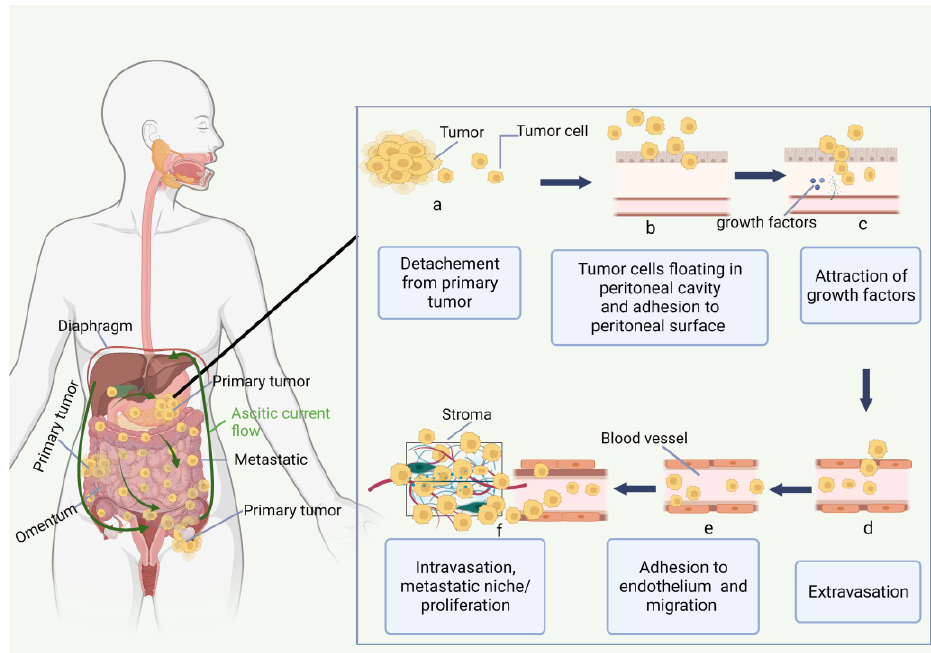
Figure 1. The development of peritoneal carcinomatosis: ( a ) The cancer cells dissociate from the main tumor and ( b ) penetrate the epithelial tissue. Cancer cells that have exfoliated invade the underlying basal lamina and stroma. ( c ) Stromal cancer cells defy apoptosis and entice growth substances that stimulate proliferation and angiogenesis. ( d ) After breaking through the endothelial cells that border the vessels, cancer cells spread to other parts of the body. ( e ) Blood vessels in close proximity to a tumor facilitate the development of distant metastases. ( f ) At a future metastatic site, cancer cells adhere to and invade the endothelium to form a new metastasis.